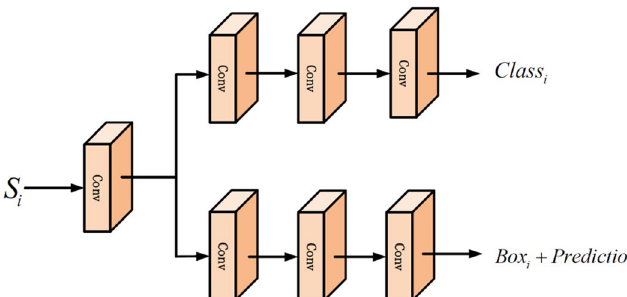
Fig. 7 SEHyp head module